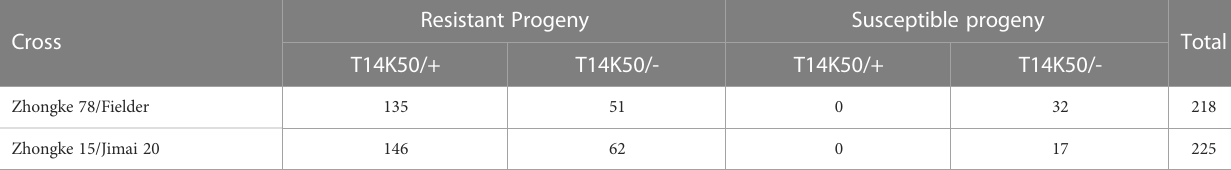
TABLE 3 Stripe rust resistance test and genotyping on two F 2 populations.